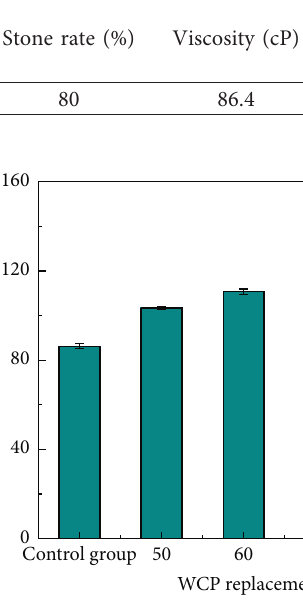
Figure 7: Viscosity at different substitution